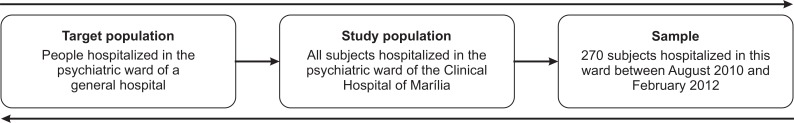
Description of sampling procedure and statistical inference